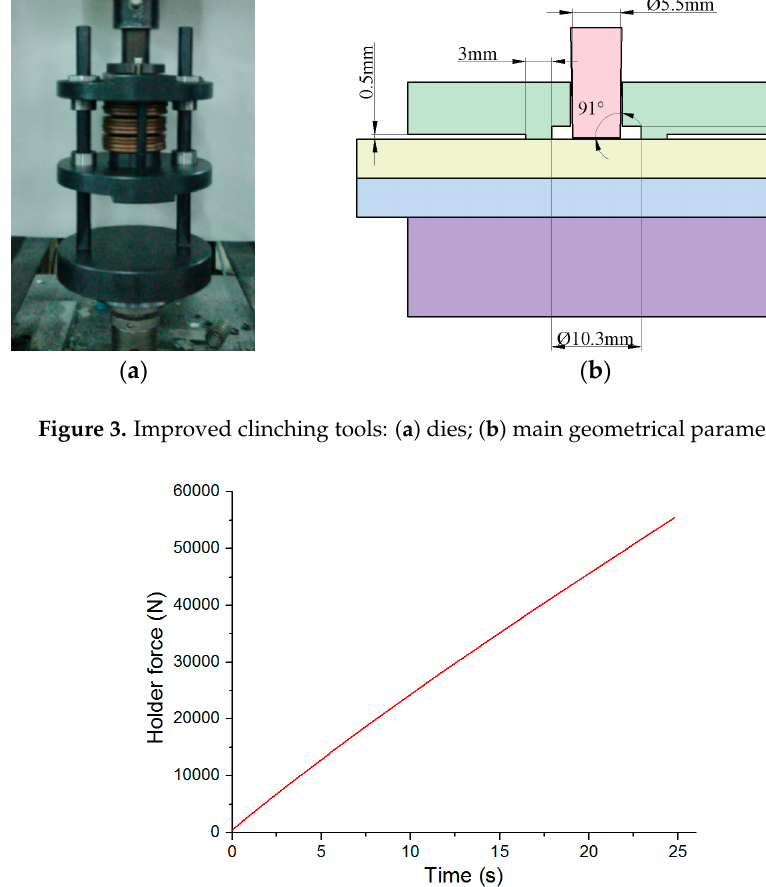
Figure 4. Holder force.